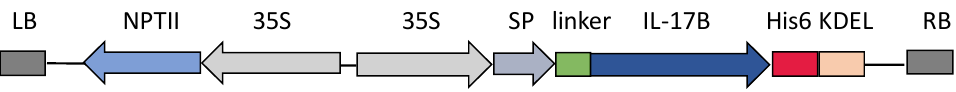
Figure 5. Schematic of T-DNA region of the expression vector construct. Abbreviations: 35S, cauliflower mosaic virus 35S promoter; SP, signal peptide of tobacco-patheogenesis-related 1a protein; His6: histidine tag; KDEL: endoplasmic reticulum retention signal; NPTII: sequence of neomycin phosphotransferase gene.